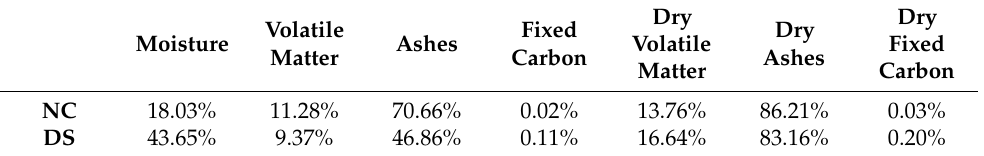
Table 2. Results from the static thermogravimetric analysis for the raw material